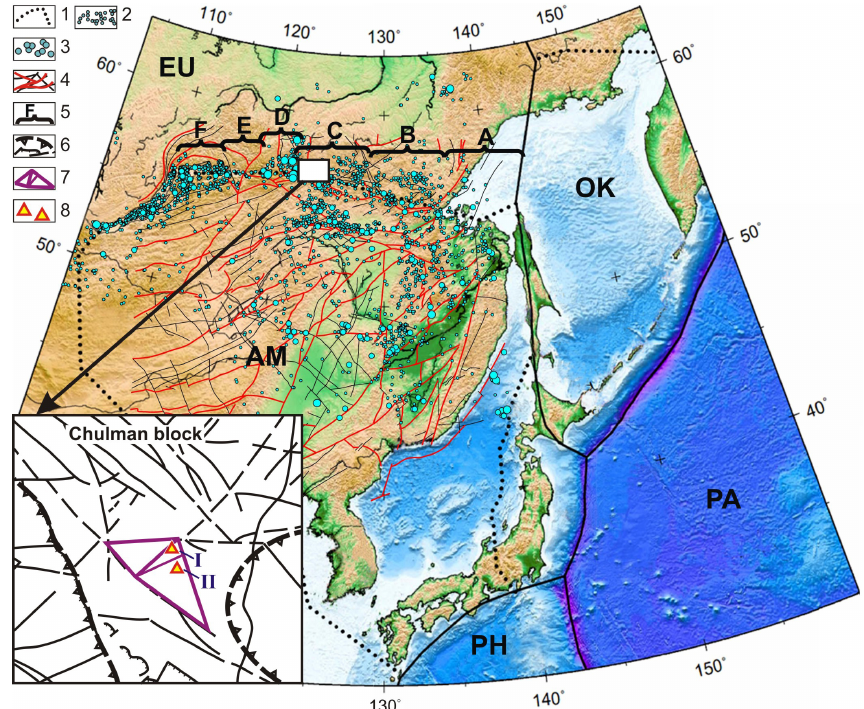
Figure 1. The distribution of earthquake epicenters in the zone of interaction between the Amurian, Eurasian and Okhotsk lithospheric plates; 1 – lithospheric plate boundaries: EU – Eurasian, PA – Pacific, PH – Philippine, OK – Okhotsk; 2 – epicenters of earthquakes with magnitude M >3; 3 – epicenters of earthquakes with magnitude M >5; 4 – main tectonic faulting; 5 – spatial cycles of seismicity. A black rectangle shows a sketch map of fault tectonics of the Chulman block, where GPS sites are located: 6 – northeast- and northwest-trending faults of different kinematics; 7 – local block, bordered by active faults; 8 – GPS sites (I – NRGR, II –